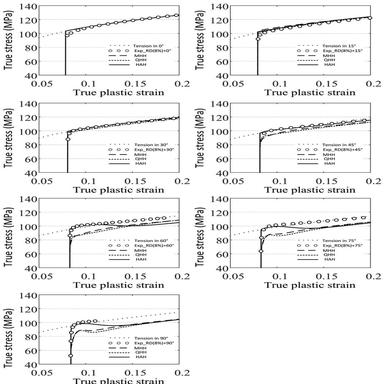
Experimental and simulated stress-strain curves in uniaxial tension at every 15° from the RD after 8% prestrain by uniaxial tension test in the RD and corresponding monotonic loading curve.